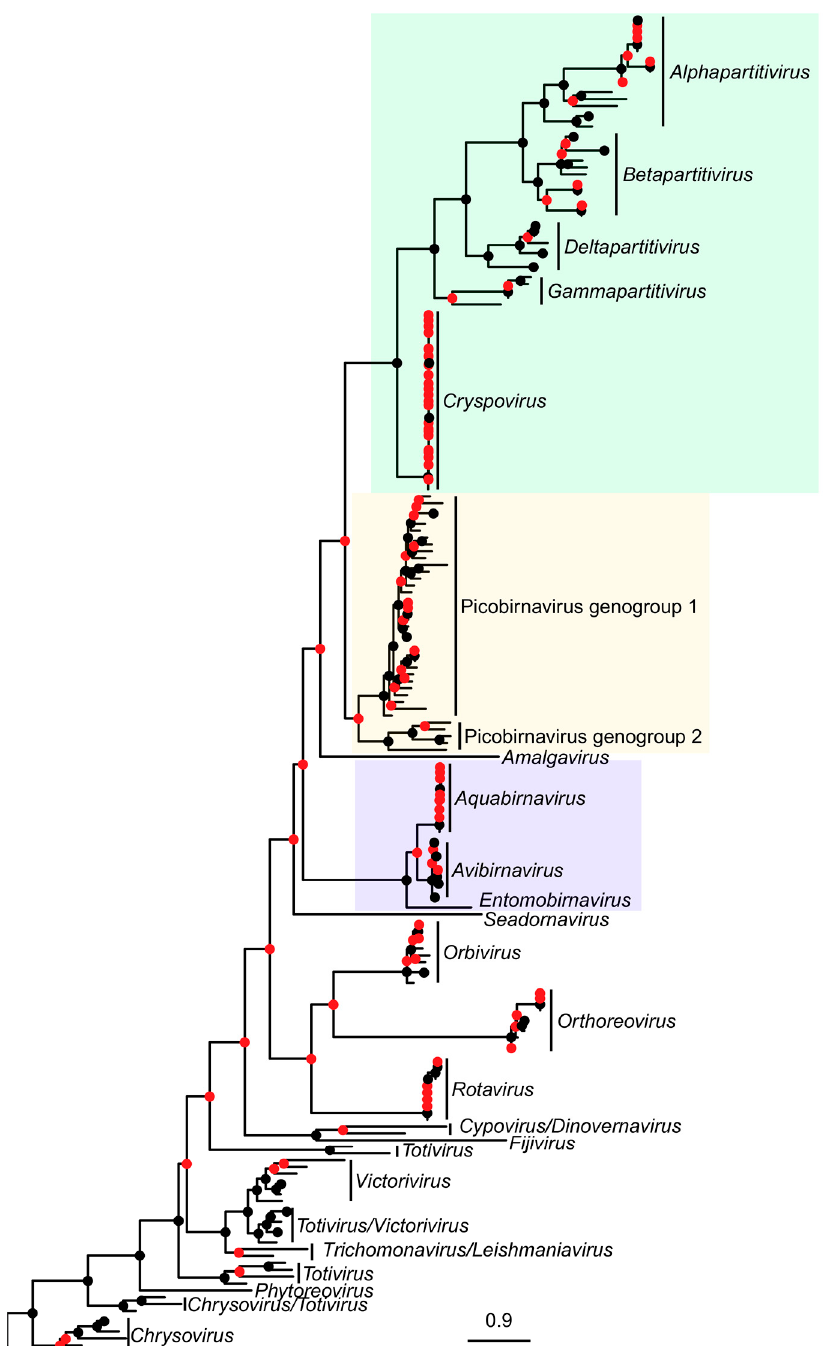
Figure 2. Maximum likelihood phylogenetic tree of RdRp amino acid sequences from picobirnavirus and representatives from other dsRNA virus families. Scale bar corresponds to 0.9 substitutions per amino acid. Putative genogroups I and II are shown in the Picobirnaviridae (gold shaded) portion of the tree. Related families Partitiviridae (green) and Birnaviridae (blue) are also shaded. Branch support values are presented as coloured nodes (black >0.8, red <0.8).